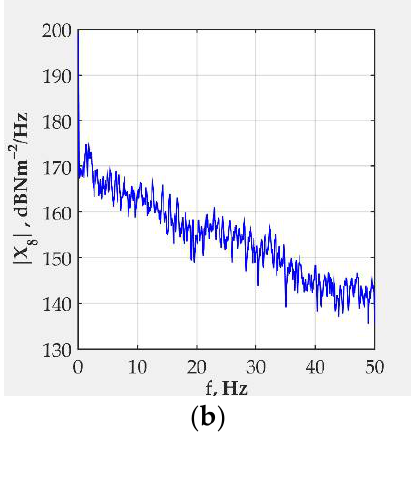
Figure 9. Magnitudes of output spectra: ( a ) X 7 ; ( b ) X 8 .